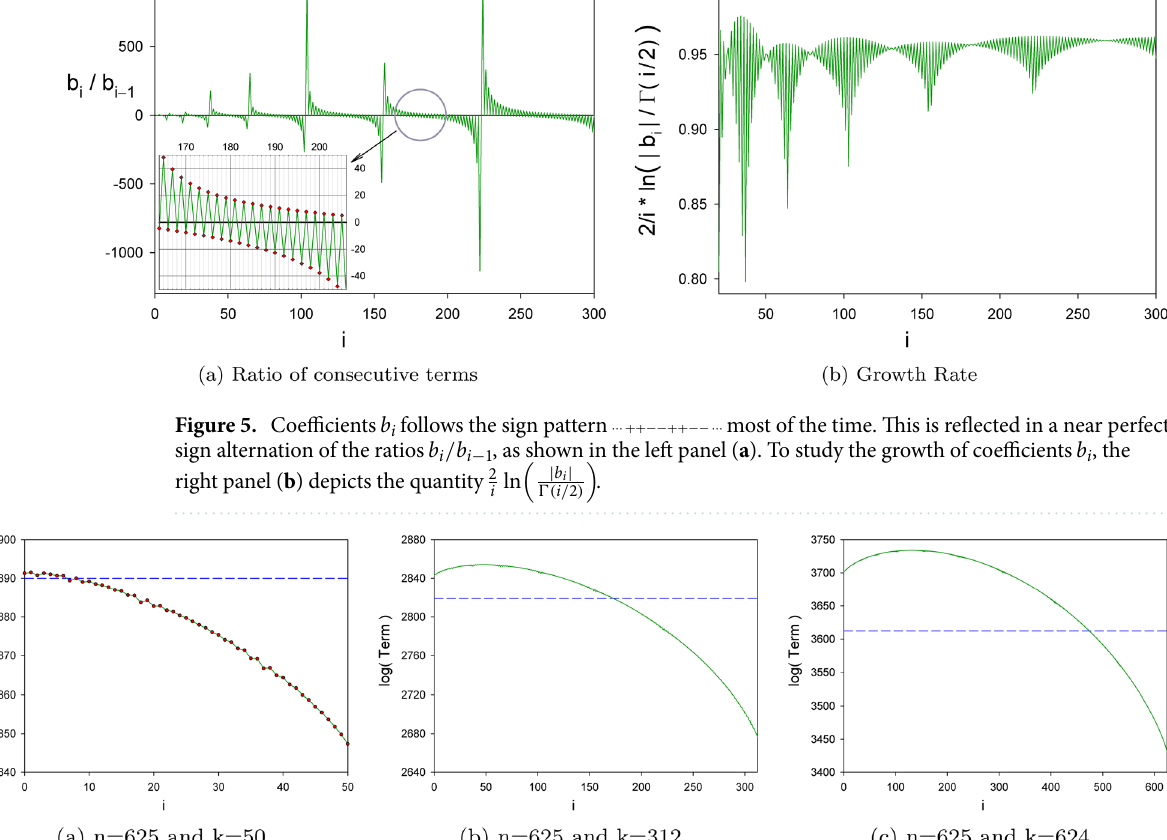
n k (cid:30) factor. (cid:31)